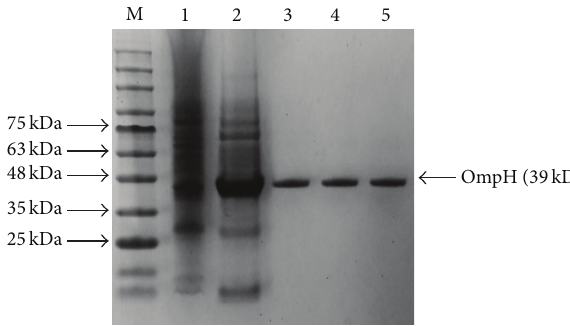
Figure 2: SDS-PAGE of proteins used in this study. Lanes: M: molecular mass standards; 1: whole cell lysate of strain X-73; 2: prepurified rOmpH; 3: rOmpH purified by electroelution; 4: rOmpH purified by a hybrid condition of affinity chromatography; and 5: native OmpH of strain X-73 purified by